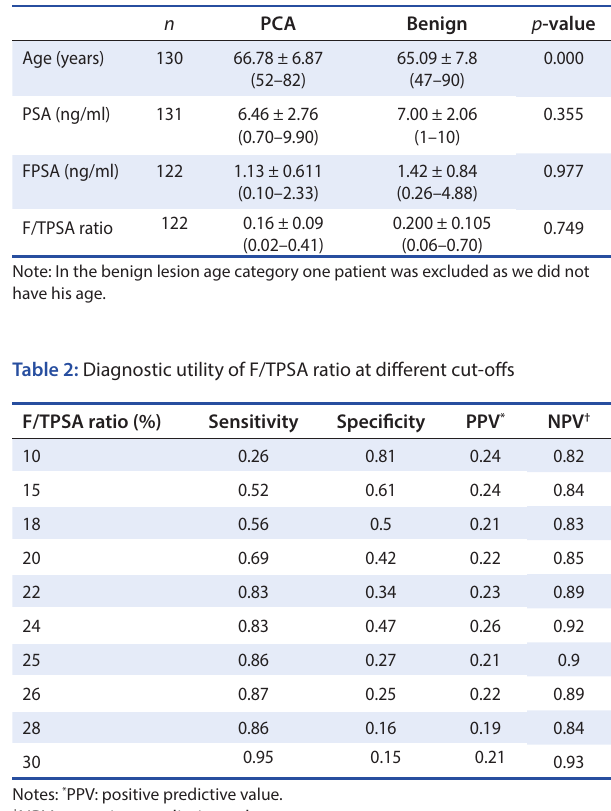
Table 1: Comparison between prostate cancer and benign prostatic lesion patients